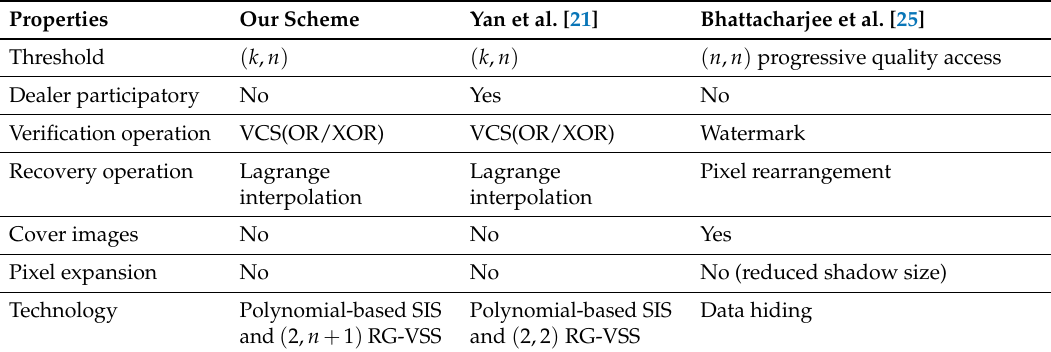
Table 1. Comparison of our scheme, Yan et al.’s scheme [21] and Bhattacharjee et al.’s scheme